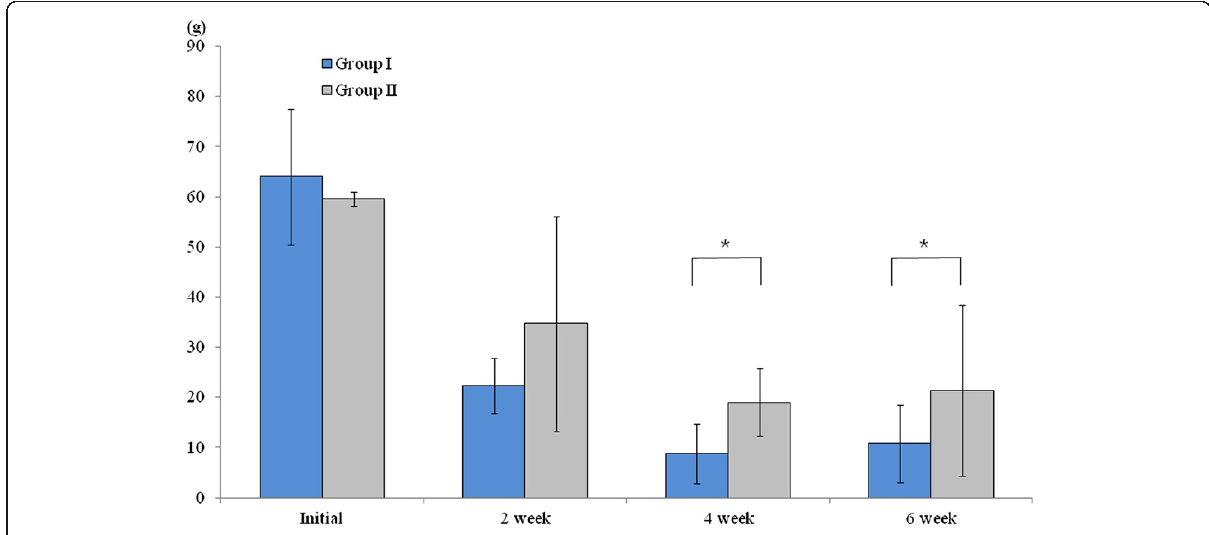
Figure 2 The assessment of sensory thresholds using touch-test sensory evaluators. Before and at 2 weeks after oxaliplatin administration, there was no significant difference in sensory thresholds between the two groups ( P>0.05) . However, at 4 and 6 weeks after oxaliplatin administration, the mean sensory thresholds of Group II with green tea(300 mg/kg orally once daily) were statistically higher than those of Group I without green tea( P <0.05). * P